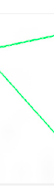
Figure 10. Calculating the distance between the angles of the center and the inner holes of a circle: ( a ) Search range; ( b ) D 0 ~D 359, the red line represents the minimum distance from the center point, the average distance from the center point, and the maximum distance from the center point; ( c ). Figure 11. Using the distance between the center of the circle and the centroid of the nut to calculate Roundness. concentricity. Blue indicates the center of gravity of the nut, green represents the connection of the midpoints of opposite sides, and red represents the center of the circle.